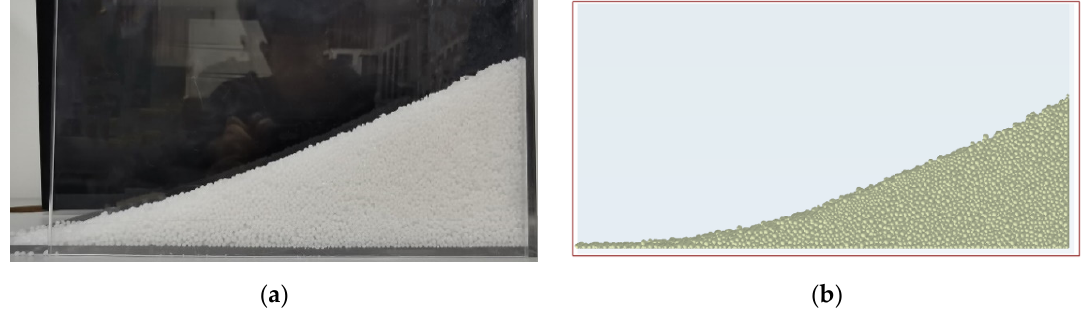
Figure 10. Repose angle test verification: ( a ) test repose angle; ( b ) simulated repose angle.